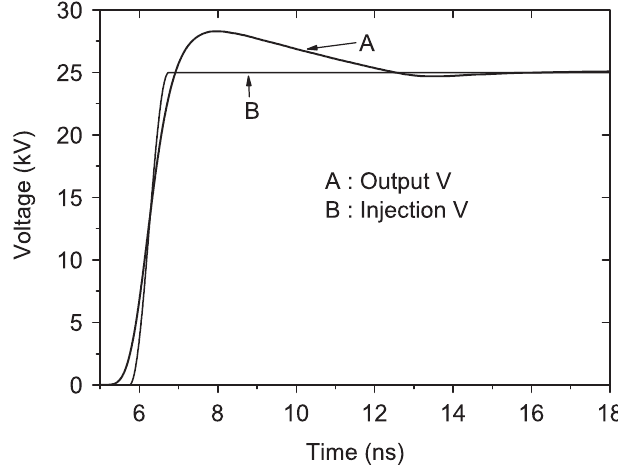
FIG. 8. Response characteristics for rise time 1 ns.